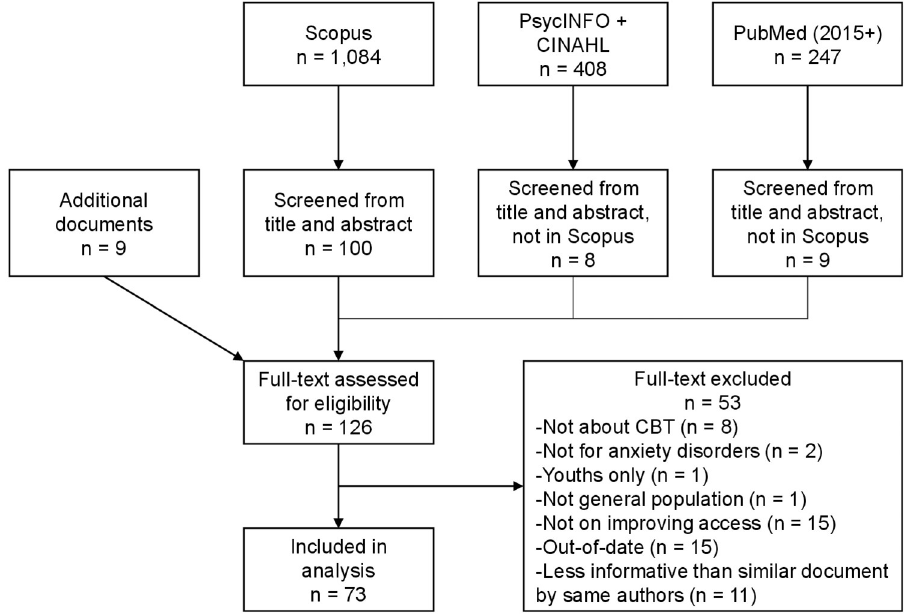
Fig 1. Flow diagram of this scoping